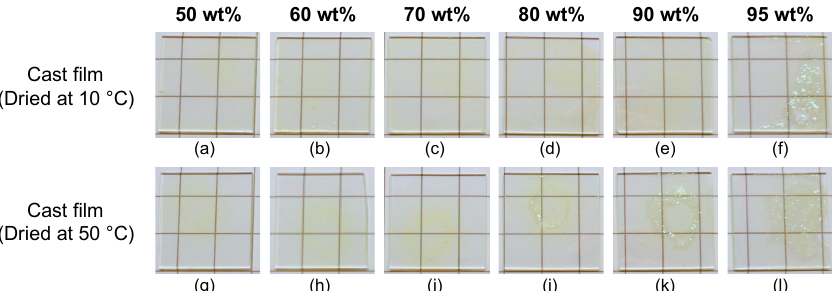
Figure 3. Photos of poly( N -hydroxyethyl acrylamide) ( p HEAAm)-based thin films with different compositions of TiNP-1 on glass plates (( a , g ): 50 wt%, ( b , h ): 60 wt%, ( c , i ): 70 wt%, ( d , j ): 80 wt%, ( e , k ): 90 wt%, ( f , l ): 95 wt%). The thin films were prepared by drop casting of the mixtures onto the glass plates and dried at 10 ◦ C ( a – f ) or 50 ◦ C ( g – l ).